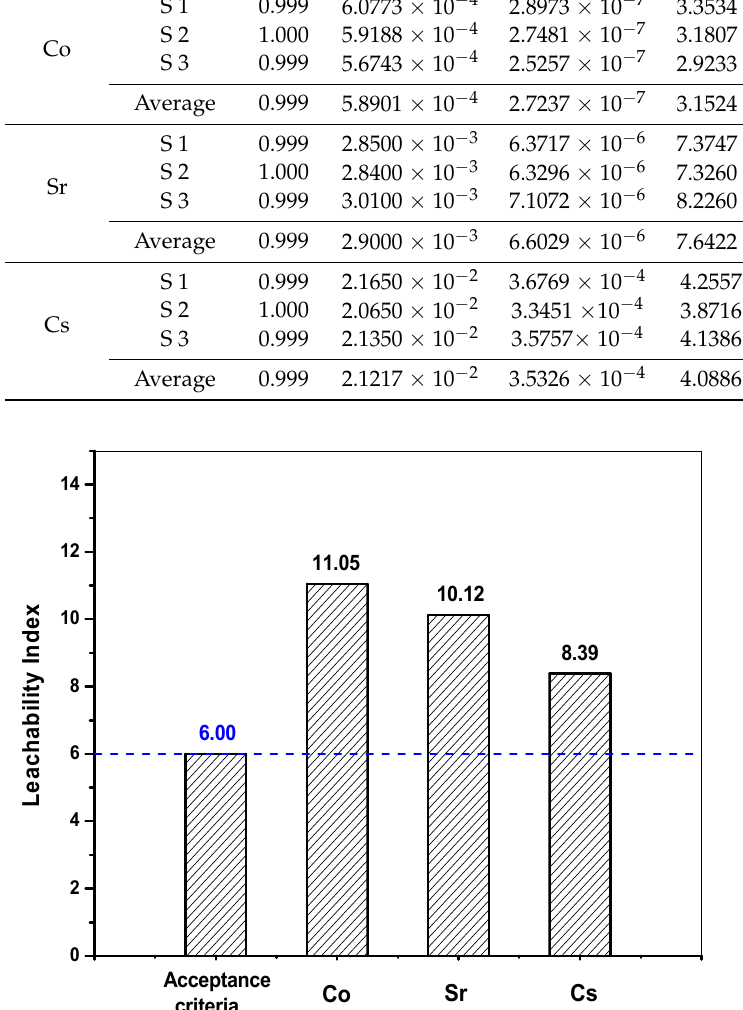
Figure 11. Leaching indexes for each nuclide compared against the WAC.